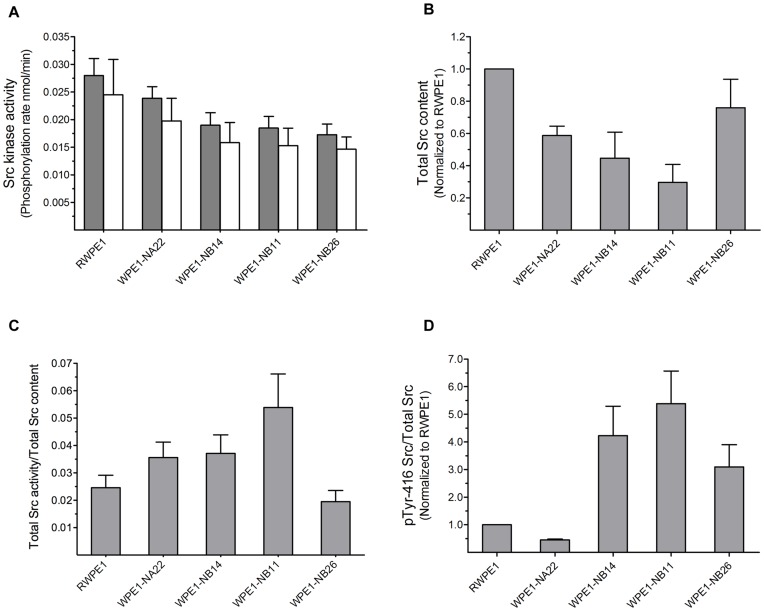
Src-catalyzed phosphorylation rates, Src protein content, and Src phosphorylation status in the RWPE1-derived cell lines.Increasing invasive ability is plotted along the x-axis. (a) Grey bars are phosphorylation rates of peptide 1 by whole cell lysates (normalized by total protein content). White bars are phosphorylation rates by cell lysates due to Src kinase alone after subtracting non-Src background phosphorylation of 1. (b) Total Src content as determined by western blot analysis (Fig. S5) (c) Src kinase specific activity as assessed by measured Src activity (Fig. 6A) divided total Src protein content (Fig. 6B). (d) pY416 levels were derived from the band intensities in the western blots (Fig. S4), normalized to the corresponding α-tubulin control, and then compared to cell line RWPE1 (RWPE1 as 1). Data are representative of at least three independent experiments and are shown as mean with SEM.